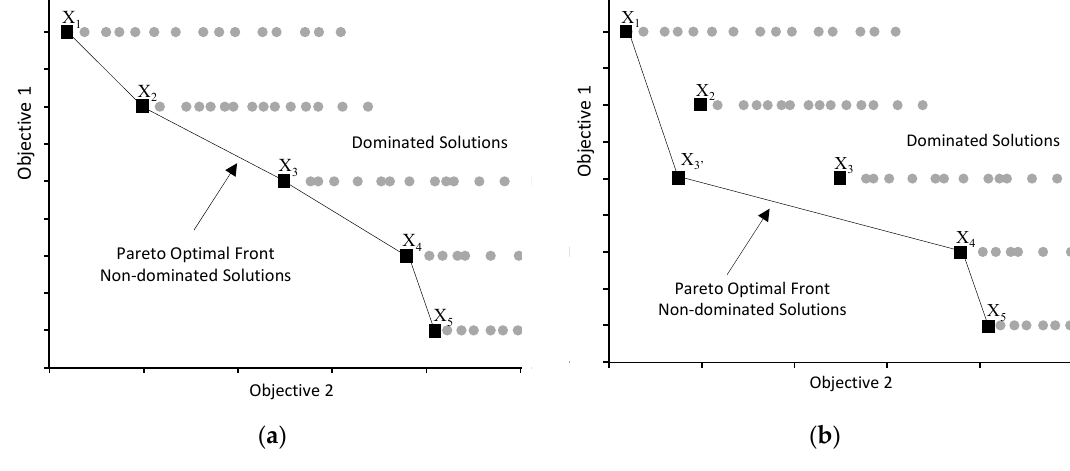
Figure 1. Pareto Optimal Front . ( a ) Initial; ( b ) Updated.